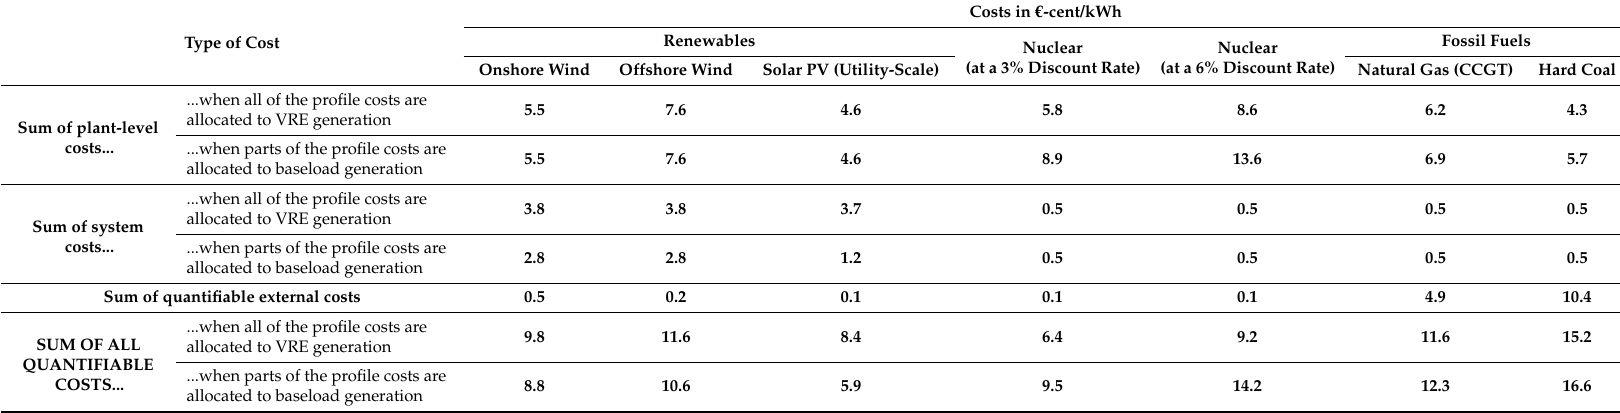
Table 14. Overview of the estimated specific social costs of electricity generation in the USA from several types of power plants assumed to start operating in 2040. Costs in € -cent/kWh Renewables Nuclear Fossil Fuels Type of Cost Nuclear (at a 3% Discount Rate) (at a 6% Discount Rate) Onshore Wind Offshore Wind Solar PV (Utility-Scale) Natural Gas (CCGT) Hard Coal Sum of plant-level costs (w/o CO 2 costs) (central values; ranges in parenthesis) Balancing costs 0.3 0 0 Profile costs (additional costs for VRE plants for shares of around 35% for wind and 15% for solar PV) Sum of quantifiable external costs 0.3 SUM OF ALL QUANTIFIABLE COSTS (with central plant-level values; with plant-level ranges in parenthesis)